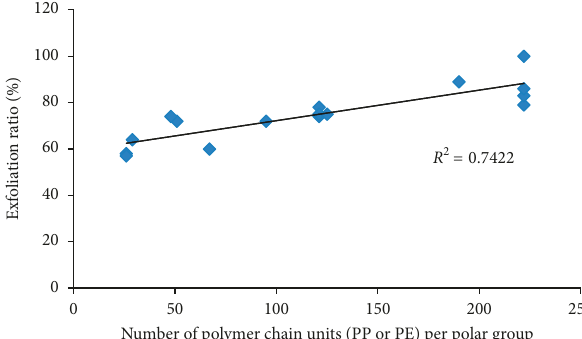
Figure 4: Nanoclay exfoliation ratio as a function of the number of polymer chain units per polar group in the